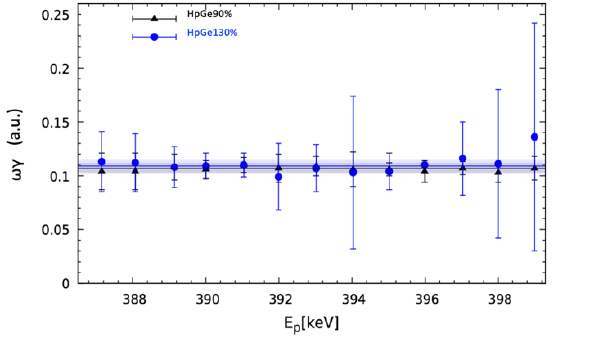
Fig. 5. The 366 keV resonance strength evaluate for each position of the scan and for the two